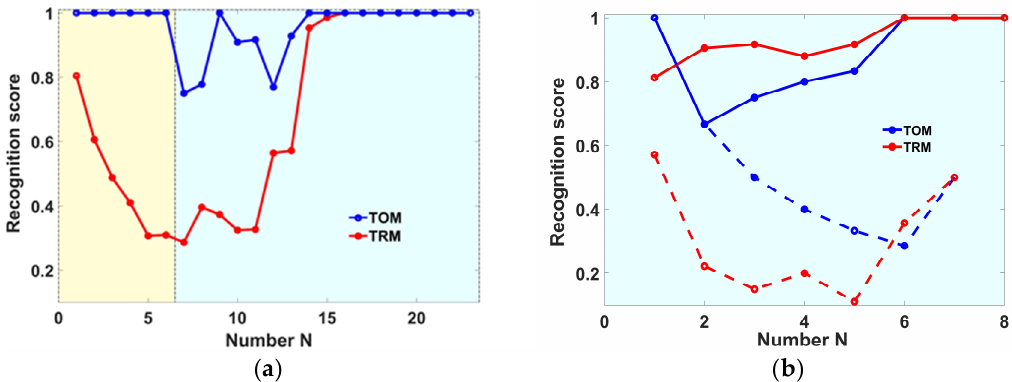
Figure 5. The S TOM ( N ) and S TRM ( N ) functions related to e-nose measurements concerning the recognition of meat freshness ( a ) and honey origin ( b ). N is number of days of e-nose measurements at the two series: ( a ) 1–6 are first series, 7–24 are the second series; ( b ) 1–7 are first series, 1–8 are the second series. At a point with the abscissa N , the training pool includes N days [34,36]. The S TOM ( N ) gives the LOO scores for this training pool. The S TRM ( N ) gives the recognition scores of all the involved E-nose measurements taken after the N th day.